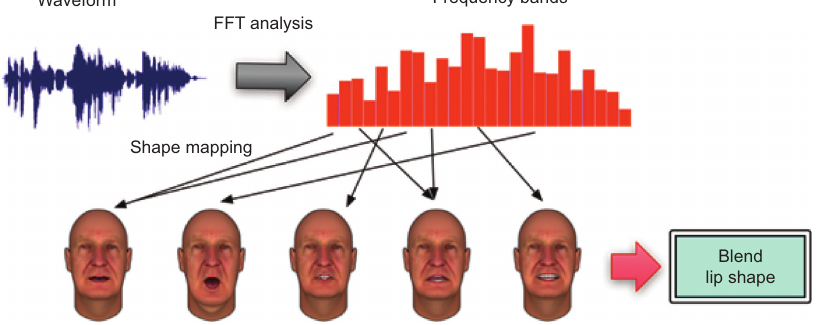
Figure 15. Recorded Voice Lip Synchronization